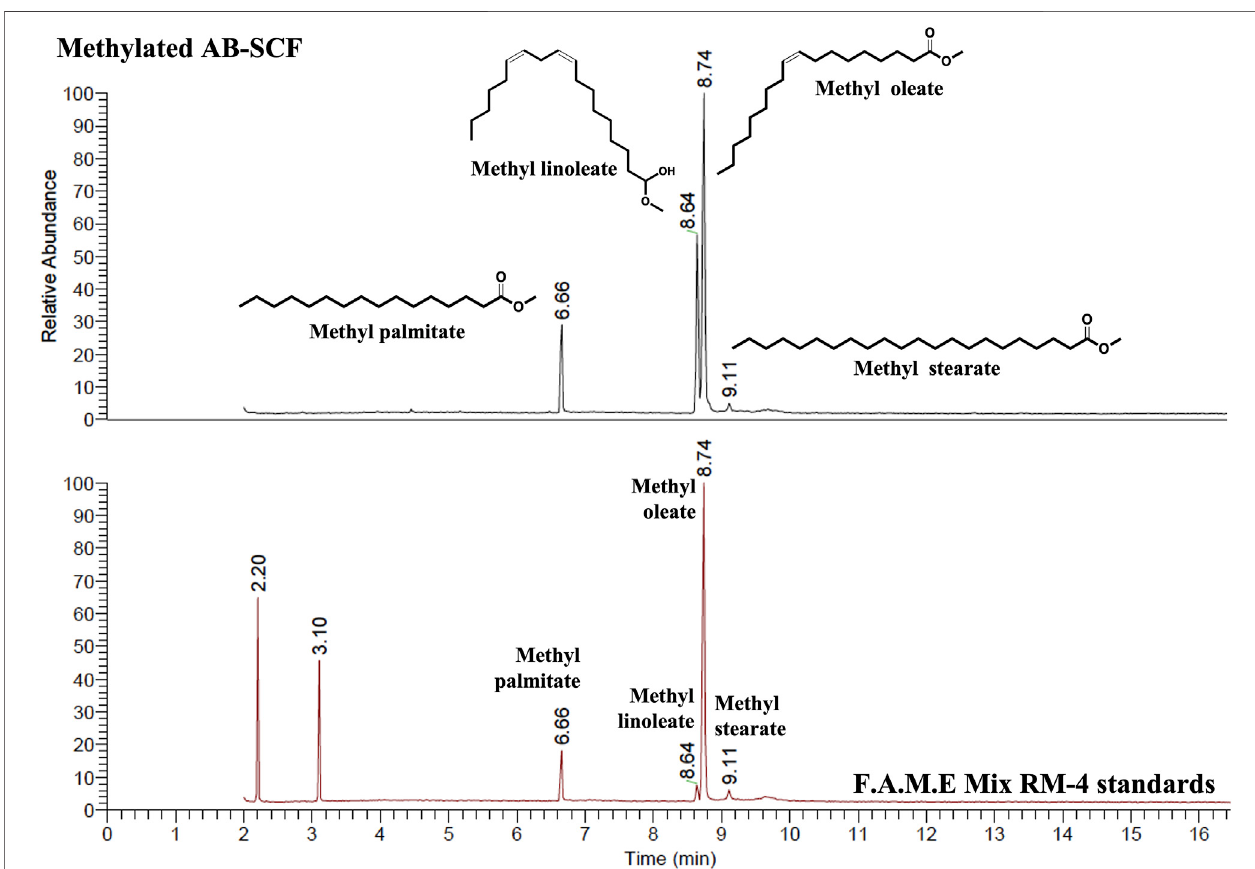
FIGURE 4 | The analytical fi ngerprint of AB-SCF methyl esters. The analysis of Major compositions and the establishment of AB-SCF fi ngerprint were carried out with a gas chromatography system (Trace GC Ulture/ITQ 900, Thermo fi sher Scienti fi c, United States) with a fl ame ionization detector (FID).